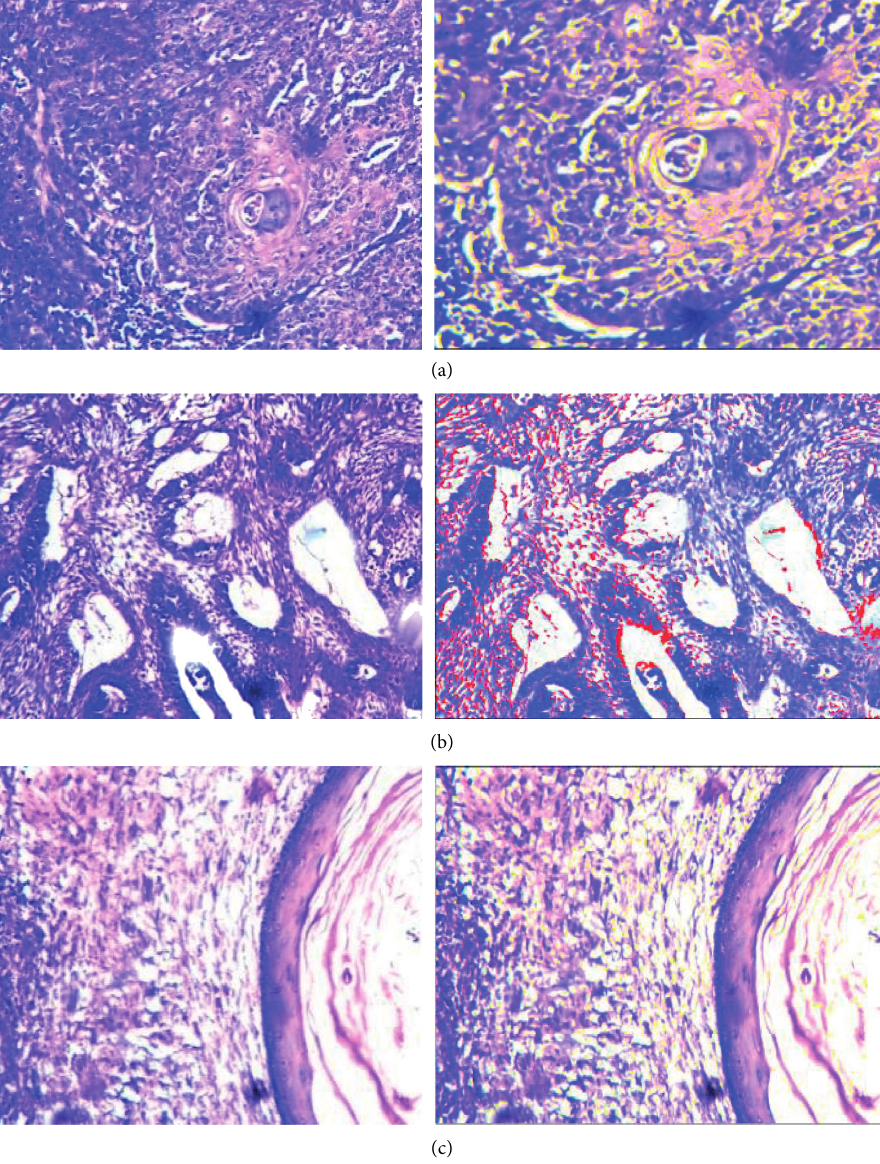
Figure 4: Cell nuclear recognition of H-E stained images. (a) Oral malignant. (b) Benign. (c)